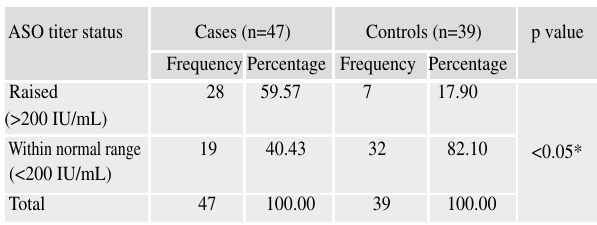
Table II: Comparison of ASO titer status between cases and controls